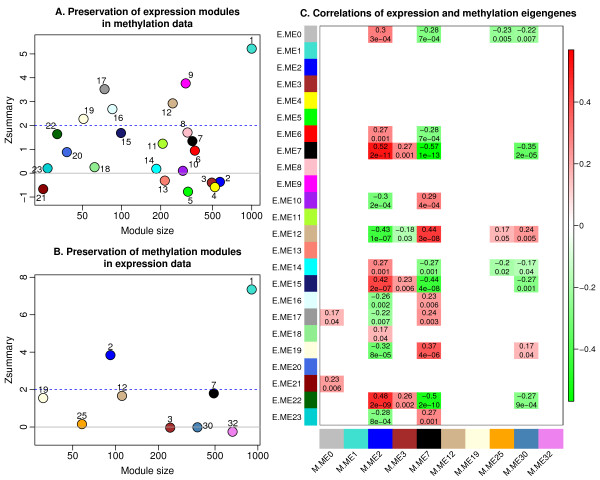
Preservation and association of co-expression and co-methylation modules. A. Module preservation statisticZsummary  that summarizes evidence of preservation of expression modules in methylation data. Each module is labelled by a numeric label and the corresponding colour. Values of Zsummary below 2 indicate no evidence of preservation; values between 2 and 5 indicate weak to moderate evidence for preservation. Only the largest module, labelled 1 (turquoise), exhibits Zsummary above 5 that can be considered moderate-strong evidence of preservation. B. Analogous plot of the Zsummary statistic for preservation of methylation modules in expression data. As in expression data, only the largest module (also labelled 1, turquoise) exhibits moderate-strong evidence of preservation. C. Robust correlations and the corresponding p-values of expression (y-axis) and methylation (x-axis) eigengenes. Each row corresponds to an expression eigengene (E.ME) labelled by numeric module label and colour. Each column corresponds to a methylation eigengene (M.ME) labelled by numeric module label and colour. Numbers in the table report the robust correlation and the corresponding p-value of the respective expression and methylation eigengenes. Only correlations whose p-value is below 0.05 are displayed. The table is colour-coded according to correlation such that (strong) green colour corresponds to (strong) negative correlations, and (strong) red colour corresponds to (strong) positive correlations.